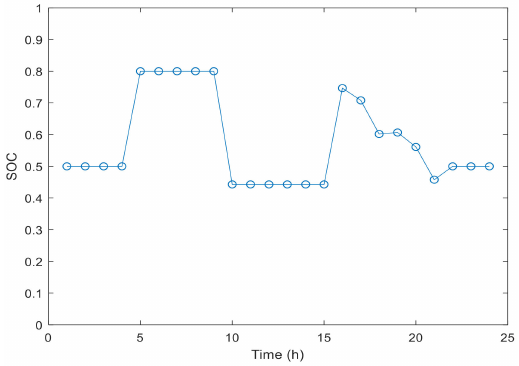
Figure 18. Aggregated value of SOC in Case